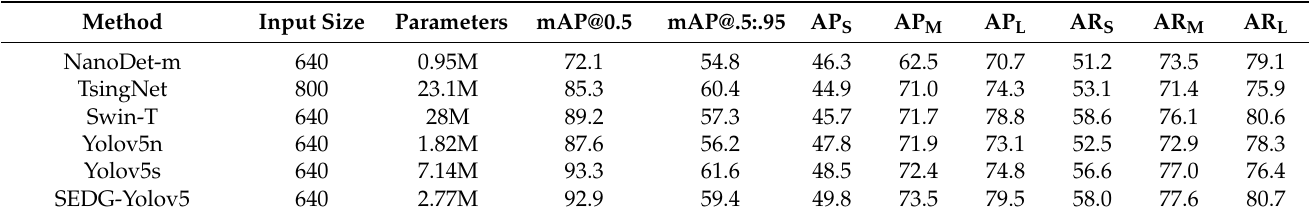
Table 4. Performance comparison with different detection models on the STSD dataset.